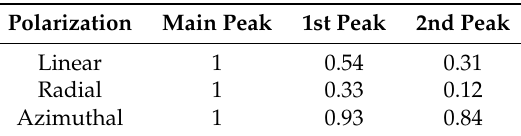
Table 1. Intensity of the diffraction